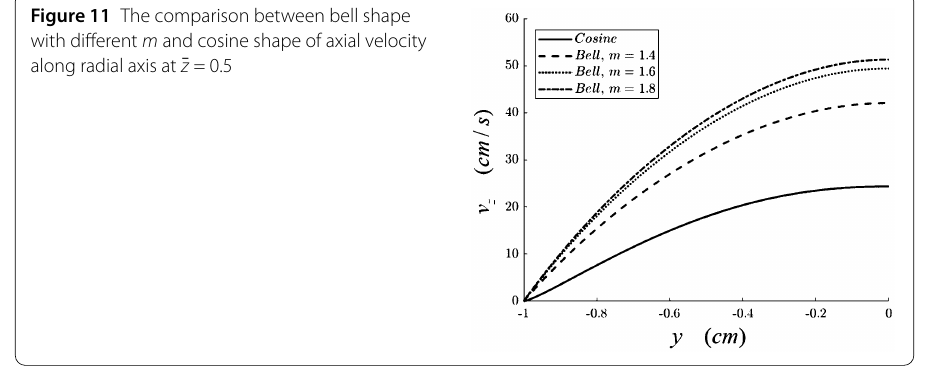
Figure 12 The comparison between bell shape with different m and cosine shape of axial velocity along axial axis at y =